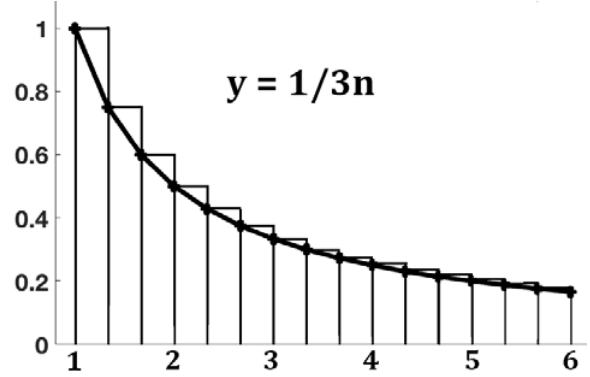
Fig. 4. The approximations of continuous function ln (x), by compressed harmonic numbers Hn[m] under m = 3.